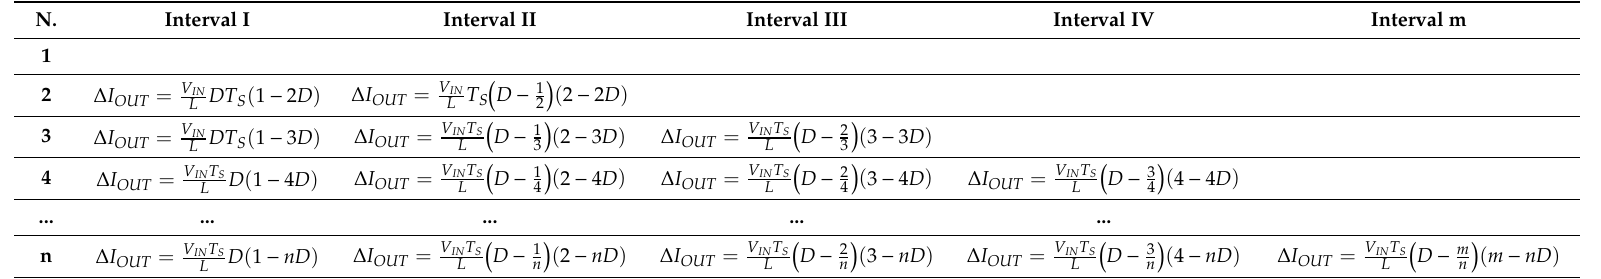
Table A2. The equations of output current ripples for the 2-,3-, 4- and